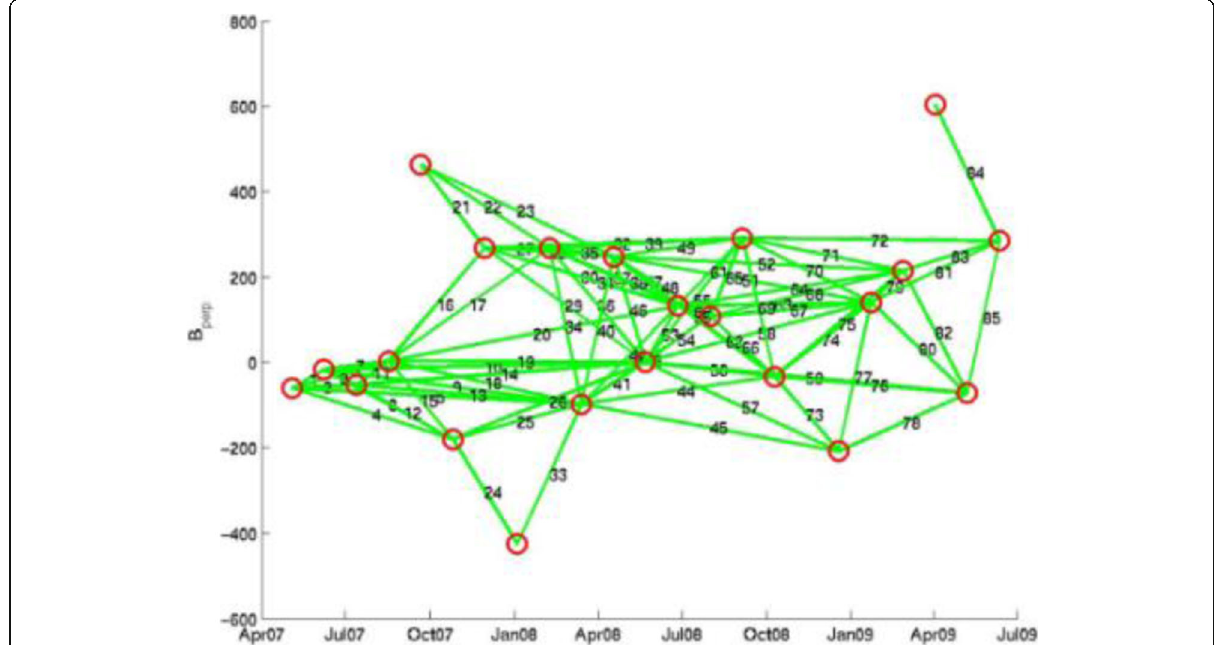
Fig. 3 Figure of short baseline interference pairs